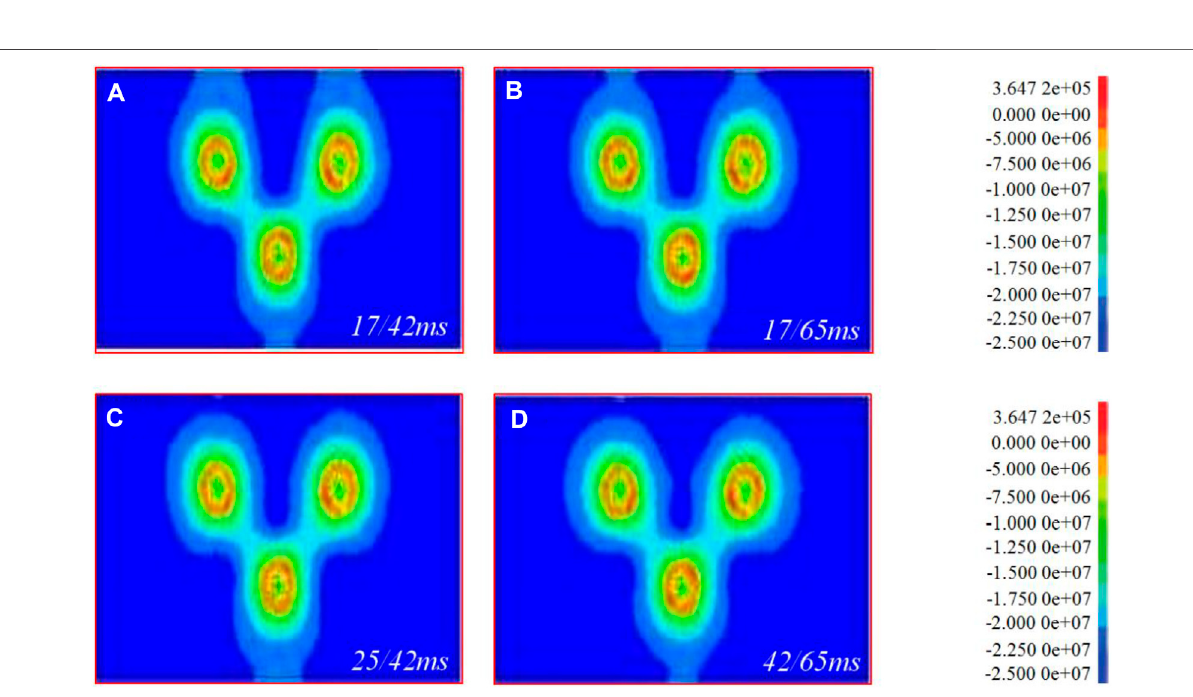
Frontiers in Earth Science |